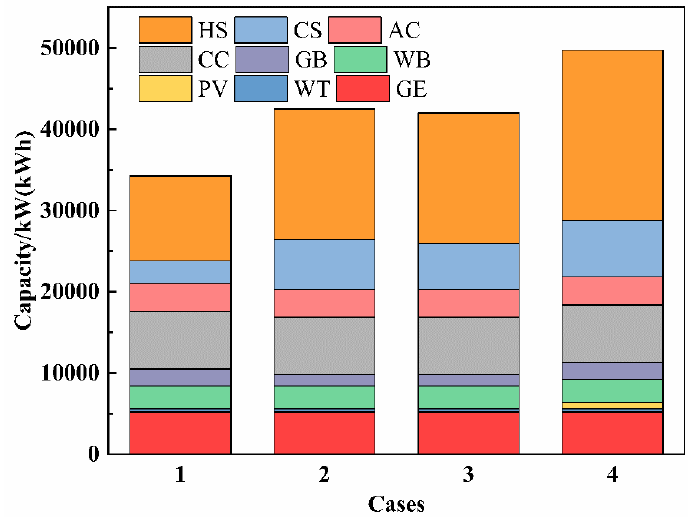
Figure 7. Optimal system configuration in the four cases.